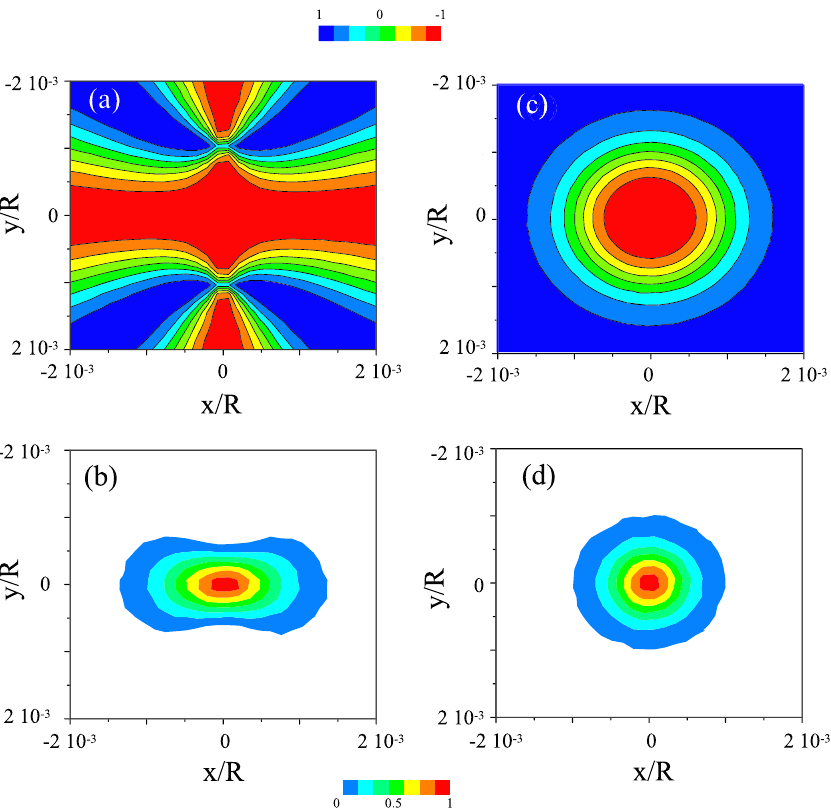
FIG. 6. ELI-NP case (beam 2): Stokes parameter S 3 (a) and S 2 (c) and photon distribution (b) and (d) for linear (left) and circular (right) polarization, with photon energy 10 MeV.